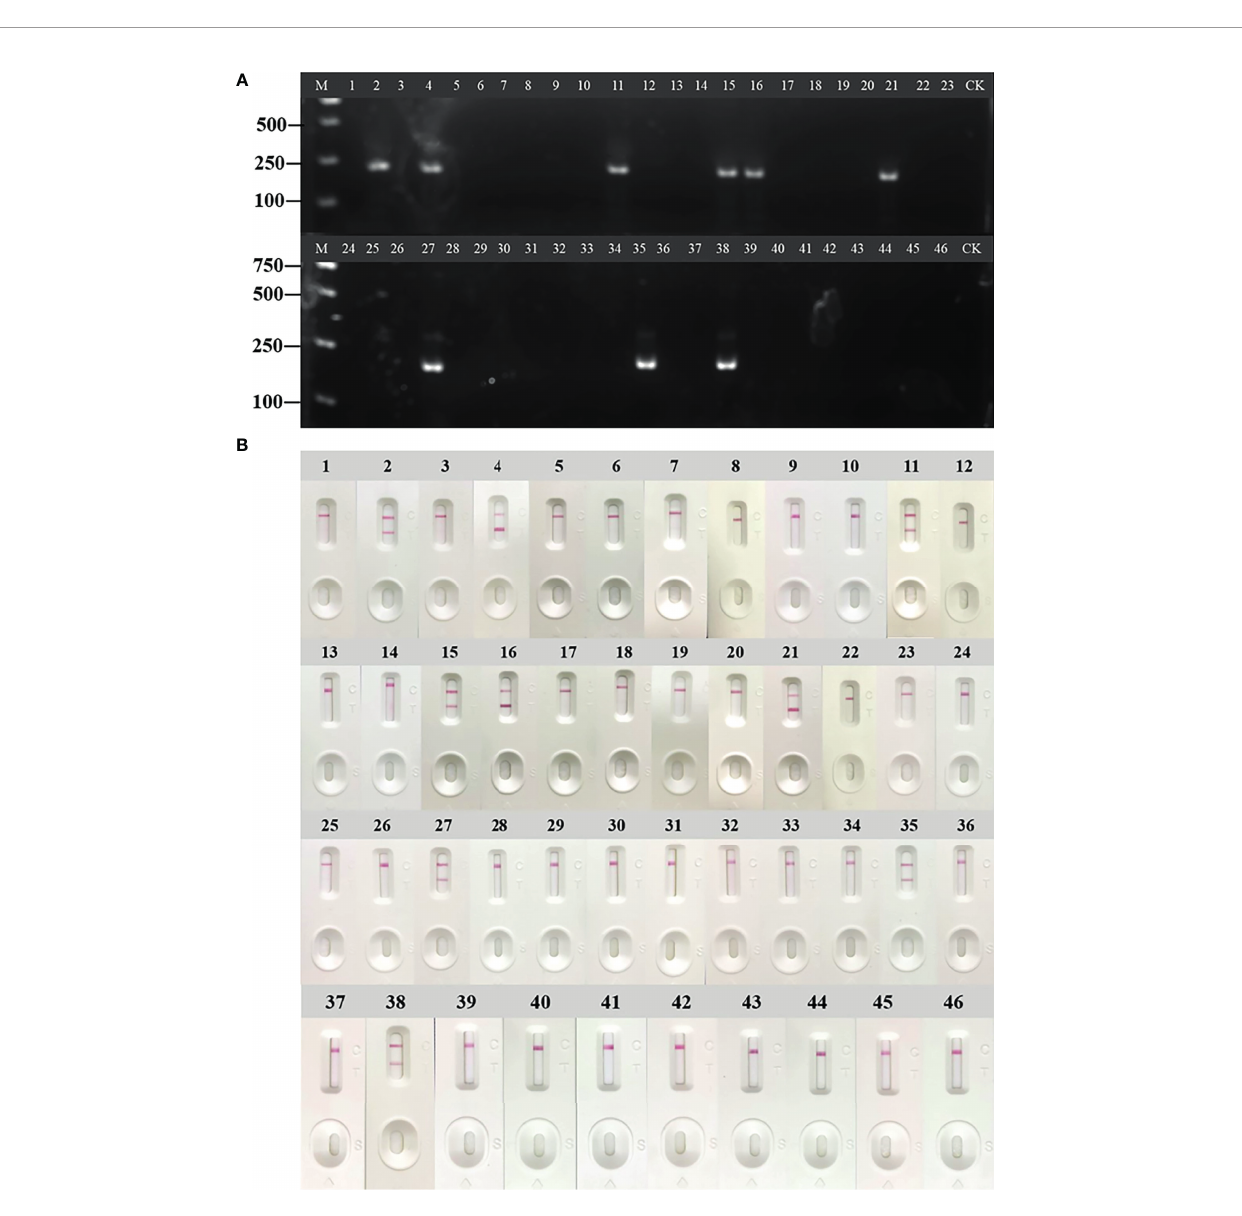
FIGURE 7 | Evaluation of reverse transcription recombinase-aided ampli fi cation (RT-RAA) and RT-RAA-lateral fl ow dipstick (LFD) in RNA extracted from clinical samples. (A) Agarose gel electrophoresis of RT-RAA. (B) RT-RAA-LFD visual readout. M, DL2000 DNA marker; 1 to 46, blood sample number; CK, negative control with double-distilled